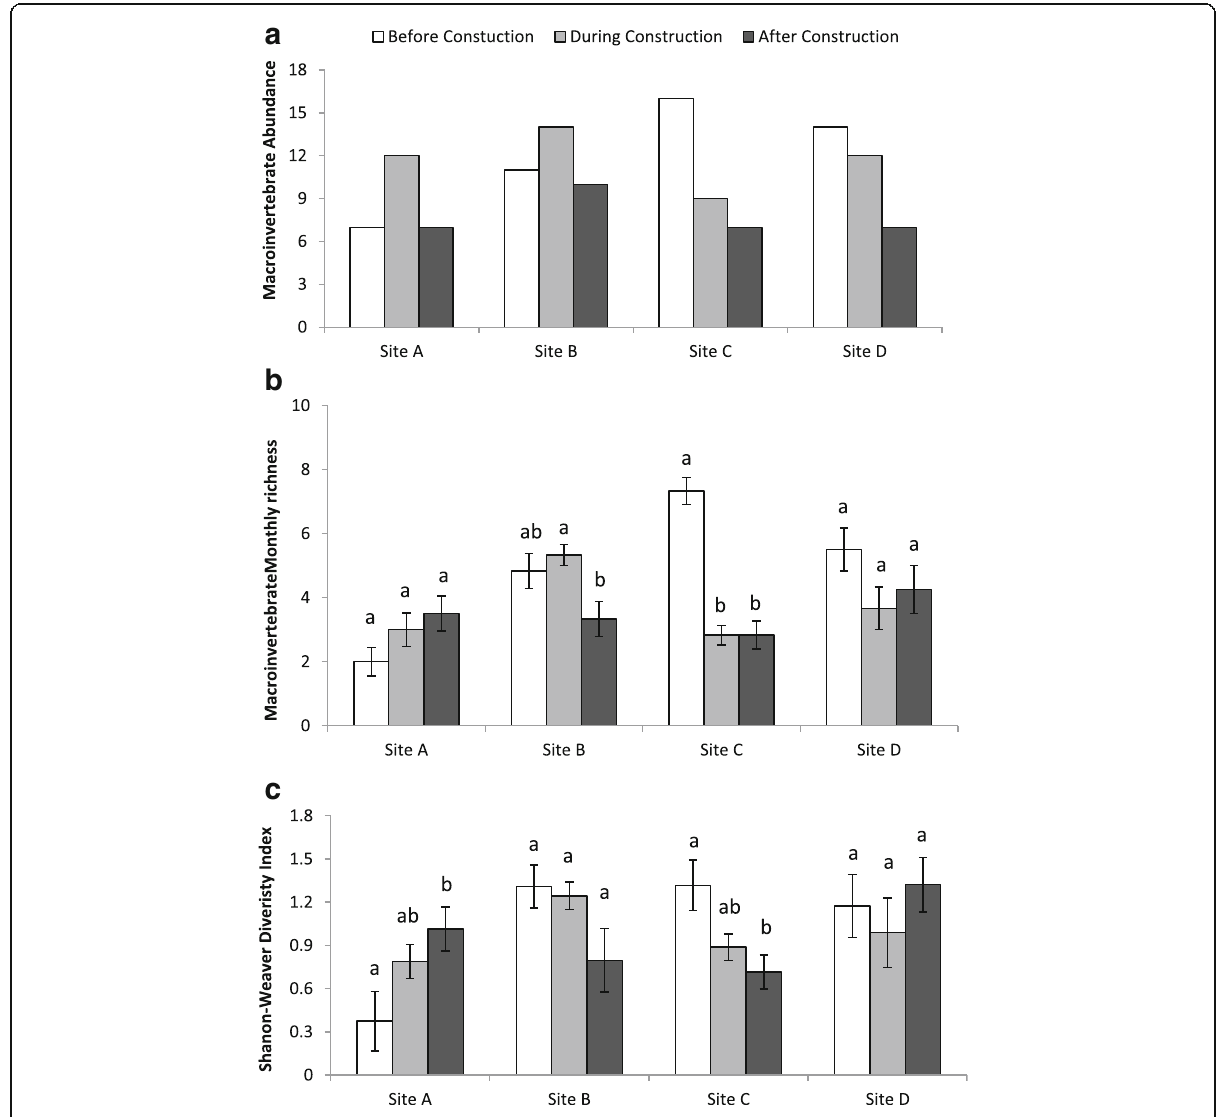
Fig. 4 Taxon abundance ( a ), monthly mean taxon richness ( b ), and Shannon-Weaver Diversity index ( c ) at the four study sites in the Park River. Data in panels b and c were represented as mean ± 1 SE. The (a, b) markings above the columns indicate the groups identified with the Tukey test ( α =